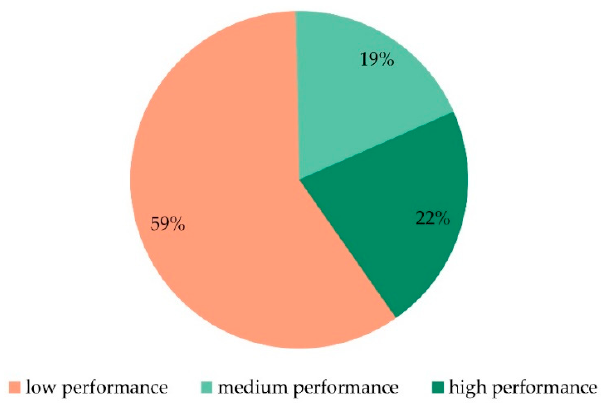
Figure 2. Share of respondents by performance category.